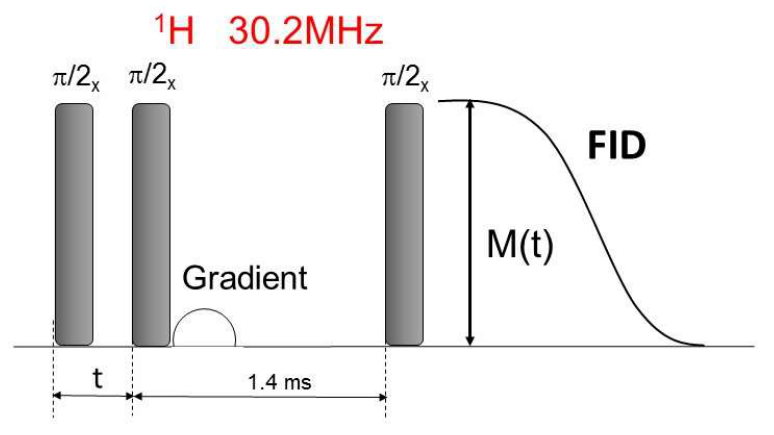
Figure 6. The pulse sequence for the measurement of the spin–spin relaxation time T 2 . After the first ( π /2 ) / x pulse at a variable time t the second ( π /2 ) / x pulse was applied. Then the gradient Gr was used to accelerate the decay of transverse magnetization components. The third ( π /2 ) / x pulse was applied after the time of about 1.4 ms, and the FID signal was